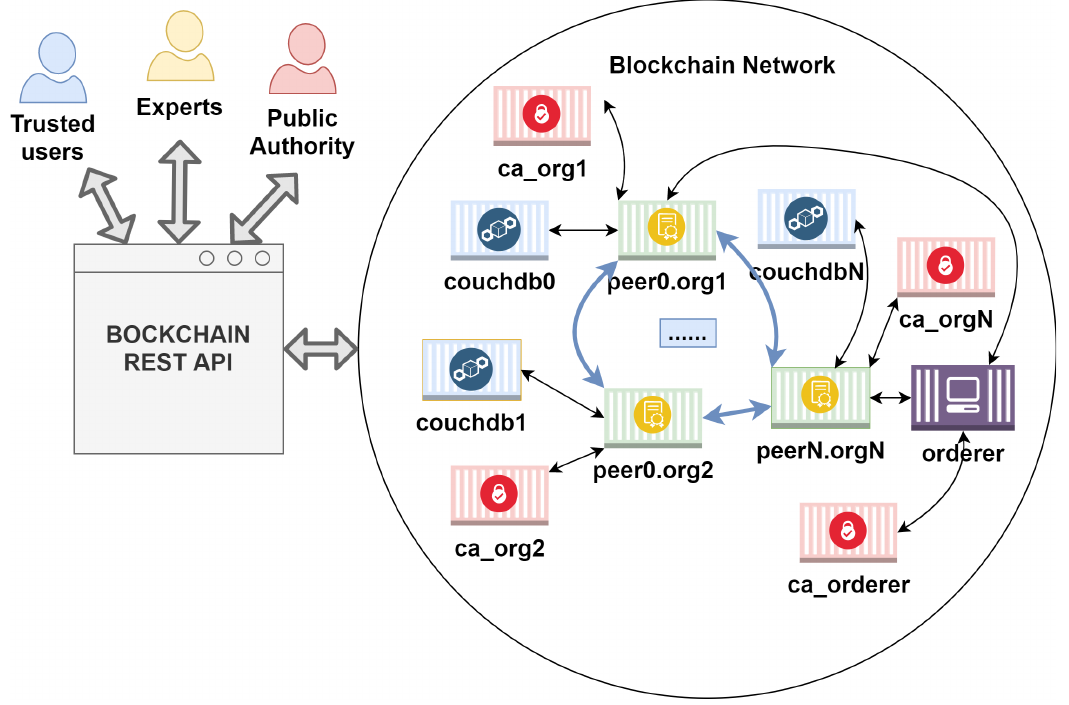
Figure 9. Blockchain architecture.